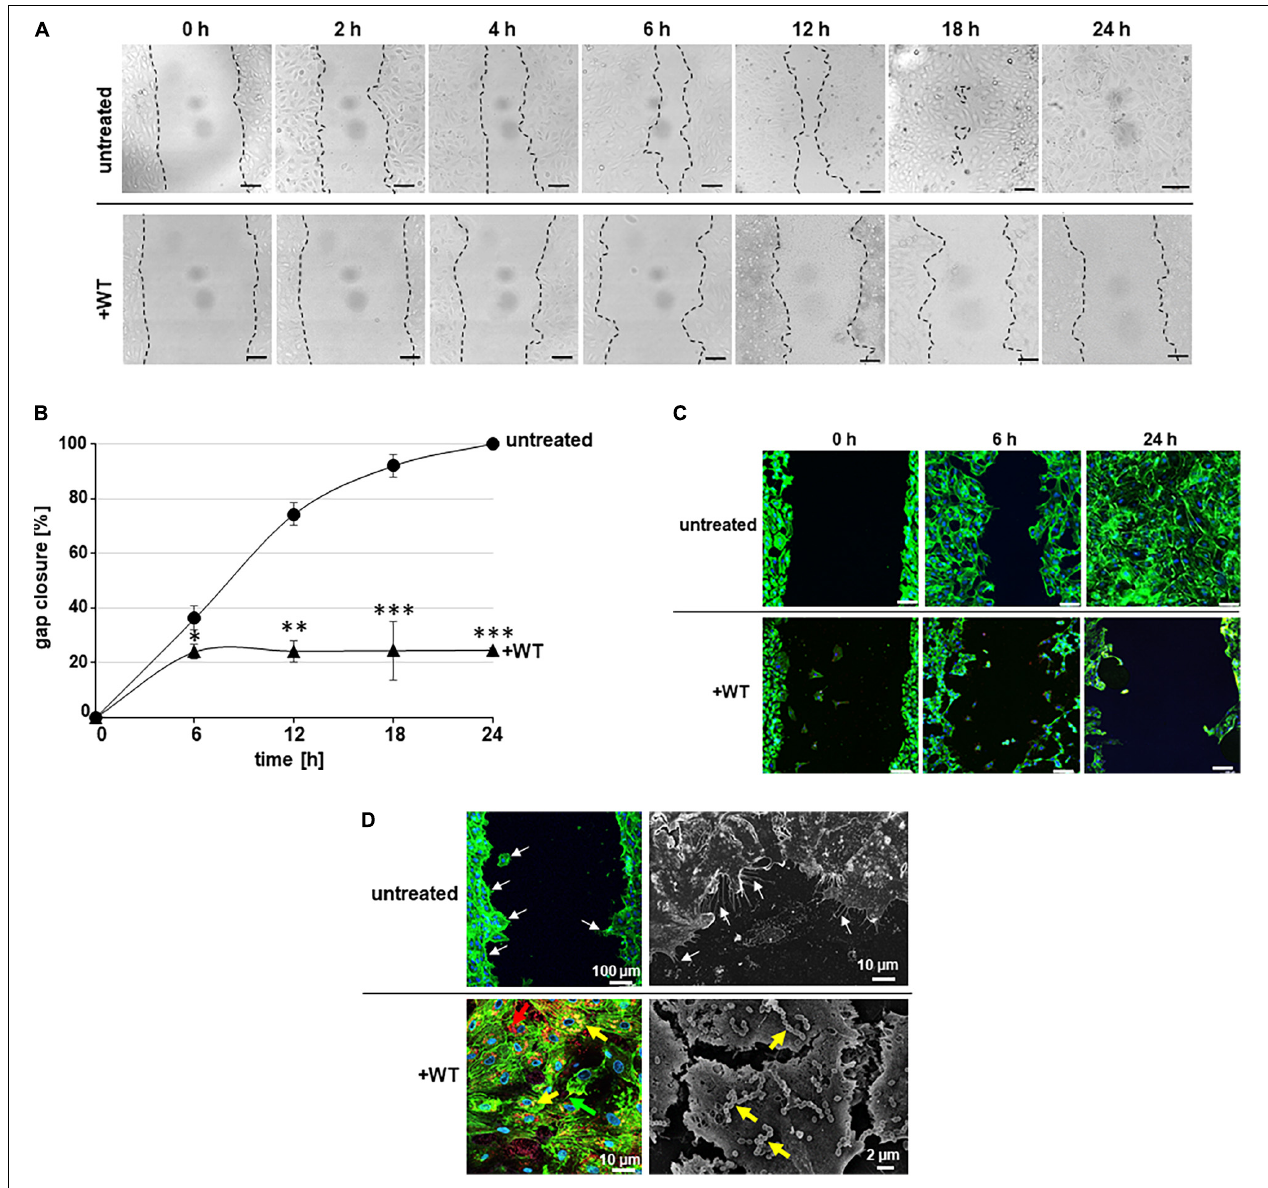
FIGURE 1 | Endothelial CSMA without bacteria and in the presence of pneumococci. (A) Representative microscopic bright-field images of CSMA probes visualize gap closure at indicated time points (0, 1, 2, 4, 6, 12, 18, and 24 h) after removal of the inlet without bacteria (untreated) and in the presence of pneumococci (+WT) at MOI of 10. Borders of cell layers at both sides of the cell-free gap were marked with dashed lines. Scale bars represent 100 µ m. (B) At indicated time points of cell cultivation, progress of gap closure was calculated in percent in relation to the starting point, which was defined as 0% gap closure. Black line with filled circles displays percentage of gap closure without bacteria, and black line with filled triangles visualizes gap closure in the presence of pneumococci (+WT). Standard deviation derived from three independent analyses performed in duplicates. ∗ indicates p < 0.05, ∗∗ indicates p < 0.01, and ∗∗∗ indicates p < 0.001. (C) Endothelial cell morphology was visualized by actin cytoskeleton detection with green fluorescent phalloidin-Alexa 488 in combination with DAPI stain of nuclei at time points 0, 6, and 24 h. Representative overlay images are shown for each time point without bacteria (untreated), and in the presence of pneumococci (+WT). Images were generated using the CLSM (Leica Sp8) at 200-fold magnification. Scale bar represents 100 µ m. (D) Fluorescence images and scanning electron microscopic illustrations of HUVEC CSMA is shown. White arrows point to cell evaginations at the growing cell borders already after 1 h of cell cultivation (untreated). In the lower panel, representative overlay fluorescence- and scanning electron microscopic images illustrate HUVEC after incubation with wild-type pneumococci. Yellow arrows point to attached pneumococci, and red arrows point to internalized pneumococci (+WT). Size of scale bars is indicated within the images.